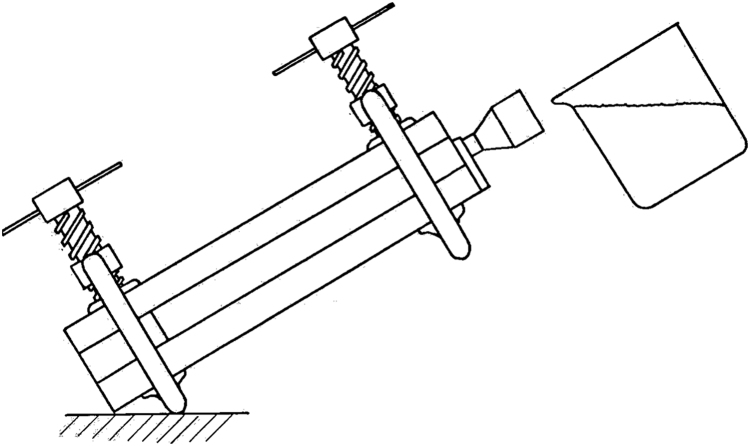
Pouring molten distilled naphthalene into the cast mold [16].